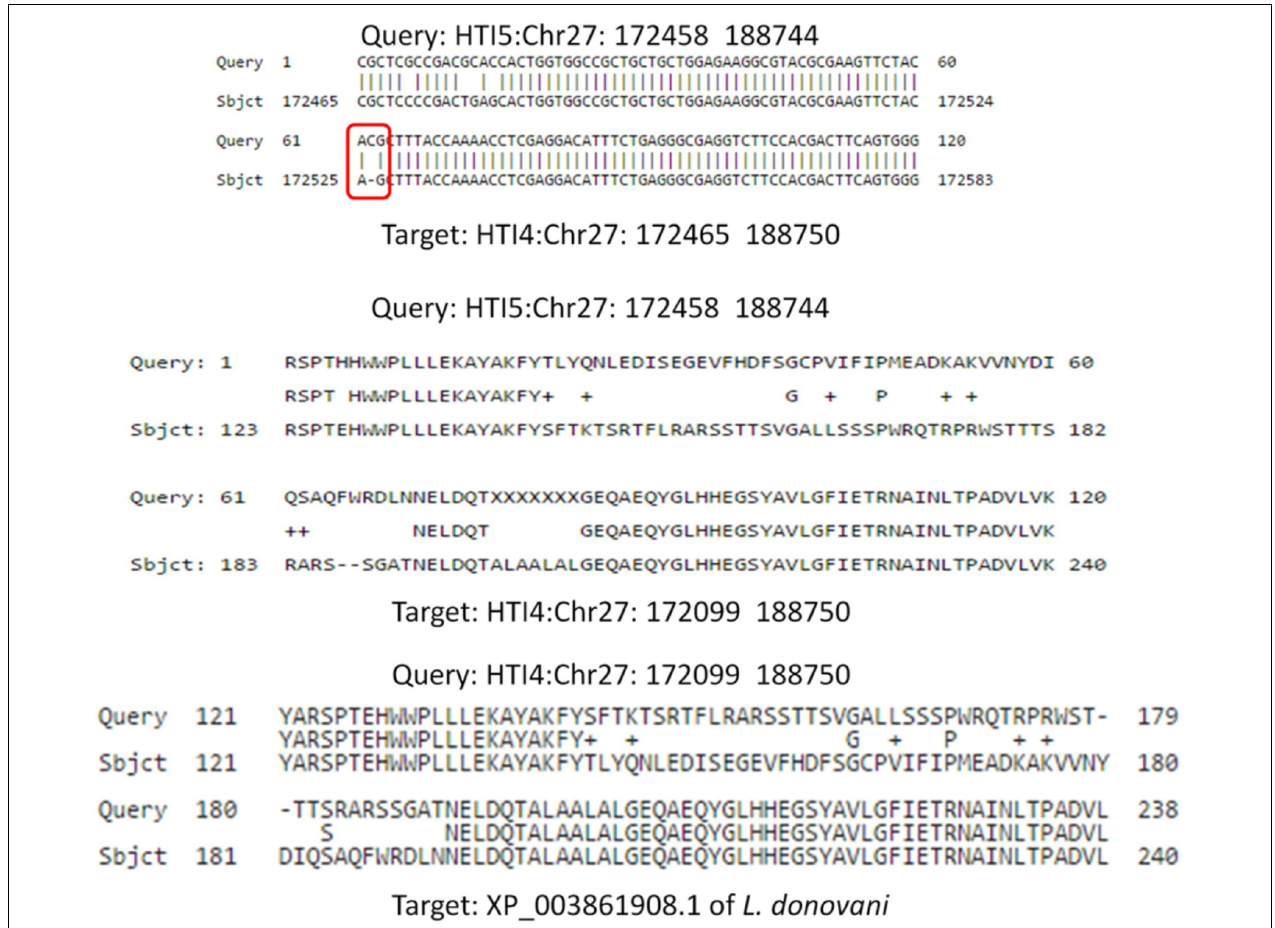
FIGURE 8 | Frameshift mutation in Calpain like cysteine protease gene due to a single insertion in late passage. A single insertion in HTI5 (as well as Genbank LDBPK 282 A1) completely changes the coding frame of the gene (Upper panel) making it inactive. The changes in late passage and Genbank strain is